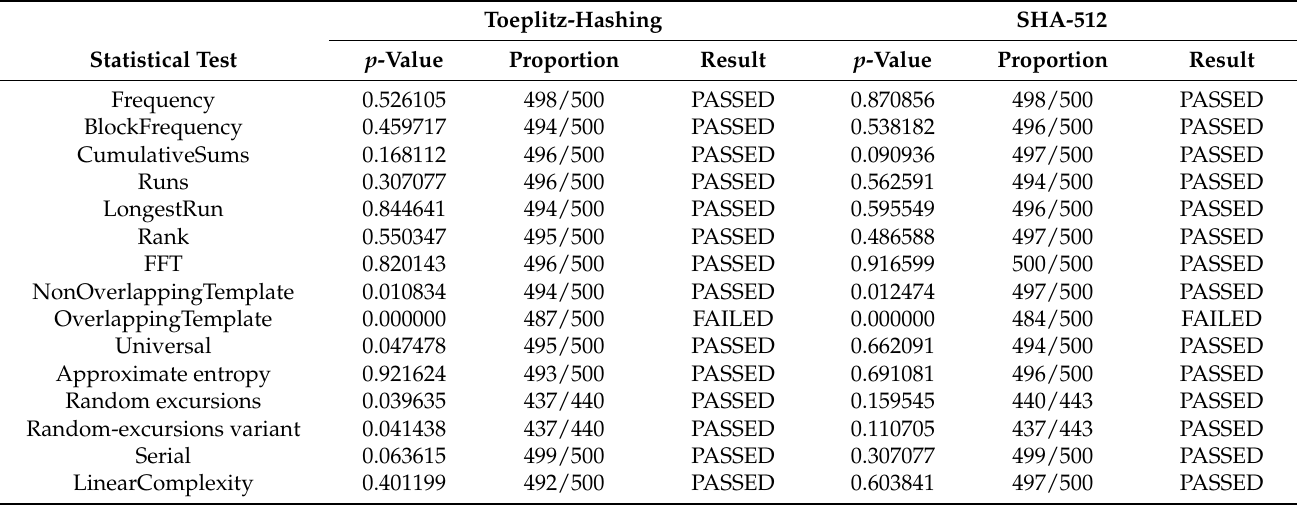
Table A3. NIST test suite with the default α = 0.01 and a bit stream length of 13,525,308 bit. The minimum pass rate is 488/500 with the exception of the random excursion where it is 429/440 for the Toeplitz-hashing extractor. For tests with multiple p -values the smallest case is